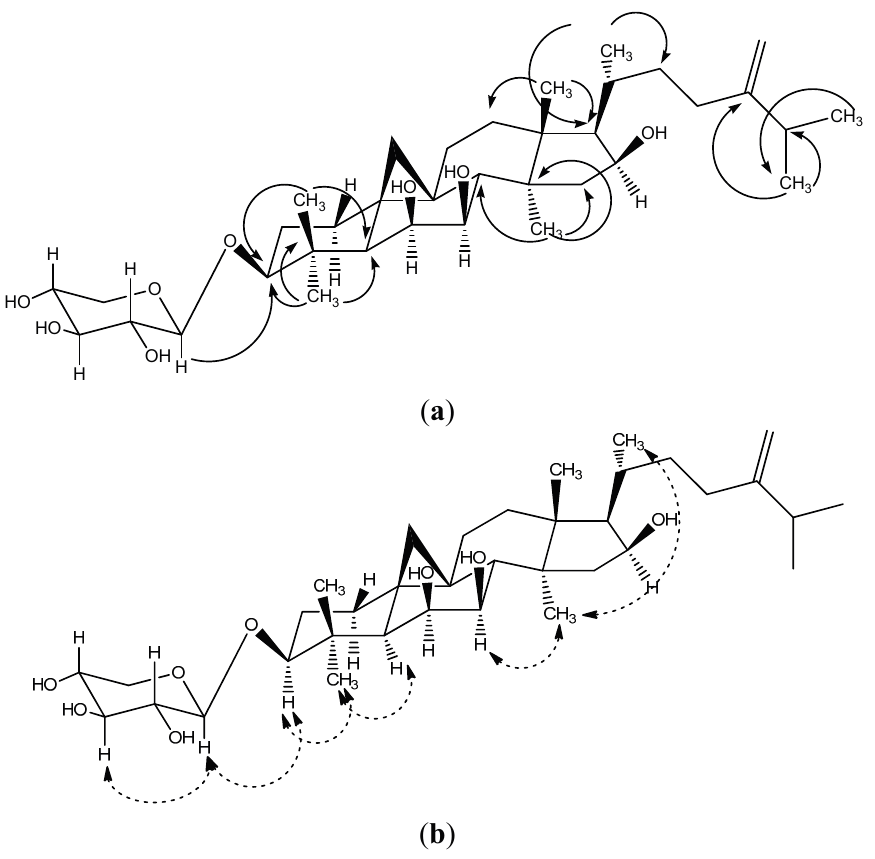
Figure 2. The key HMBC ( a ) and ROESY ( b ) connections of riparsaponin ( 1 ).